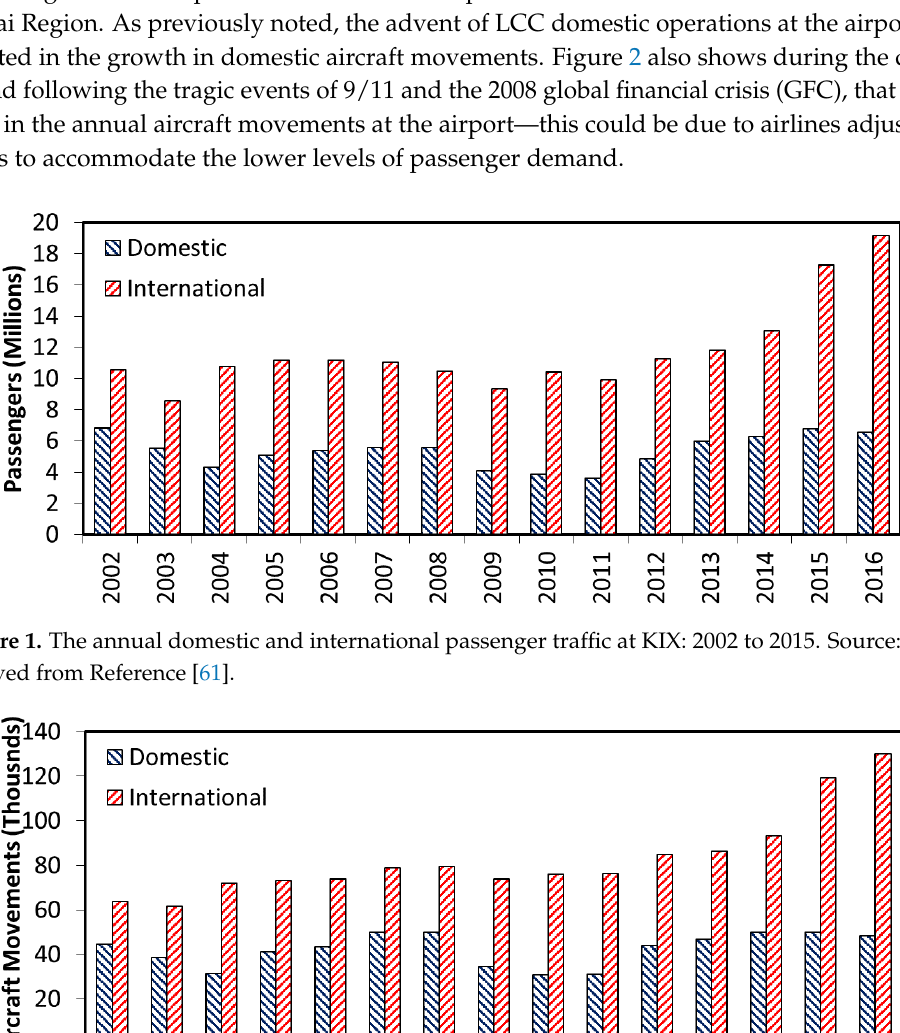
Figure 2. The annual domestic and international aircraft movements at KIX: 2002 to 2015. Source: data derived from Reference [61]. derived from Reference